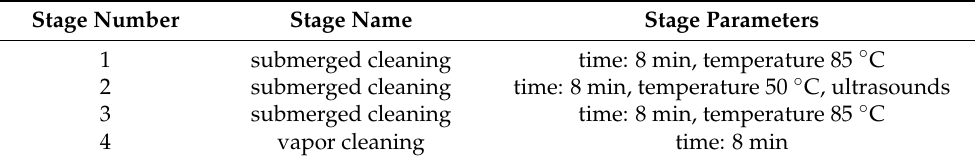
Table 1. The cleaning process parameters of AISI 1045 samples made in ultrasonic